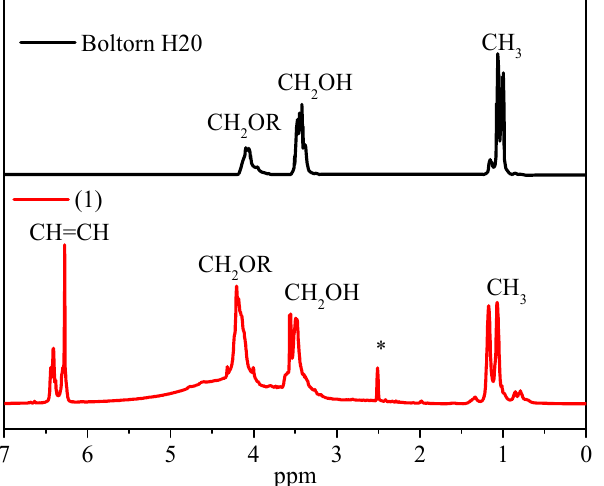
Figure 2. 1 H NMR spectra of the original hyperbranched polyester polyol (Boltorn H20) and com- pound 1 ; *—DMSO proton resonance.